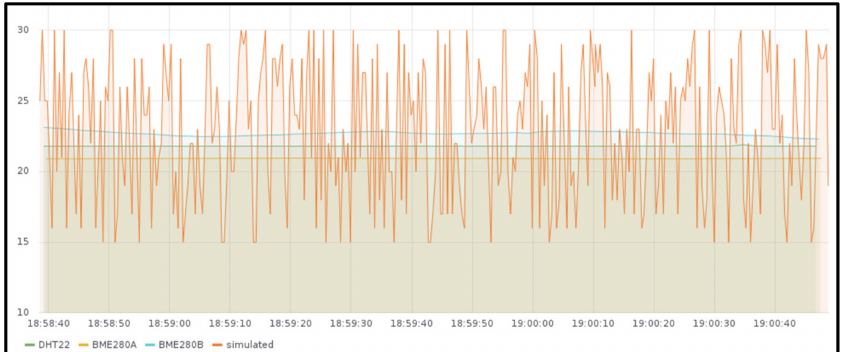
Figure 7. Temperature generated by BME280 and DHT22 sensors together with some emulated background tra ffi c measured at the IoT gateway deployed in Google Kubernetes Engine cluster.